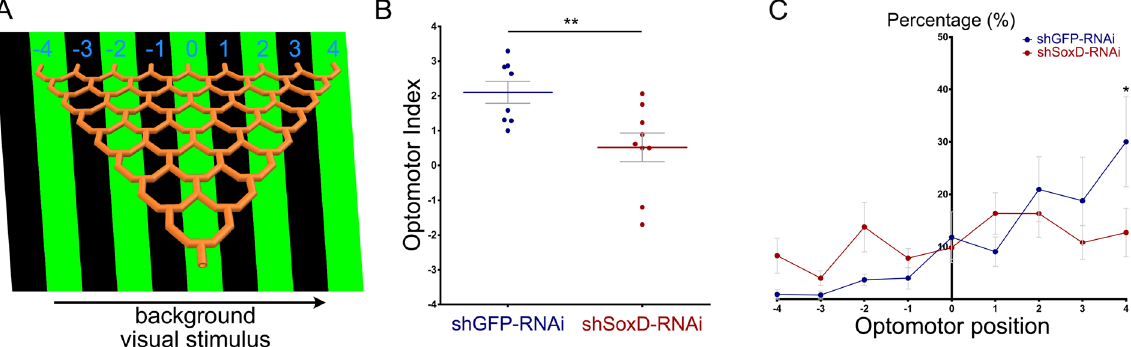
Figure 5. SoxD knockdown affects optomotor response. ( A ) Diagram of the optomotor paradigm. An eight- choice maze is attached to a screen that displays green and black strips moving to the right. Flies enter the maze from its bottom and exit in different optomotor positions in the top of the maze. ( B ) Graph showing the Optomotor Index (OI) of control shGFP-RNAi and shSoxD-RNAi driven by IPC-GAL4. ( C ) Plot showing the percentage of flies in each optomotor position of control shGFP-RNAi (blue lines) and shSoxD-RNAi (red lines) driven by IPC-GAL4. Mann-Whitney test was used for OI, while 2-way ANOVA with Bonferroni’s multiple comparison test were used for optomotor positions. * and ** are p-value < 0.05 and 0.01